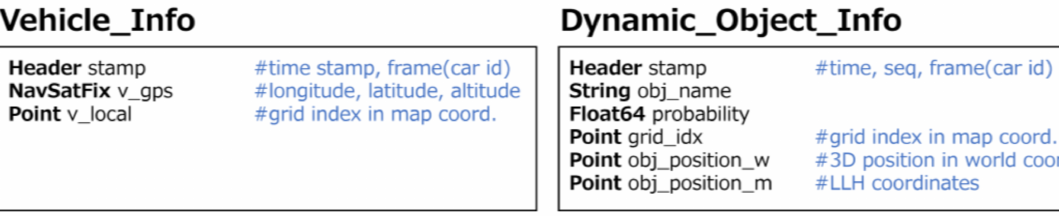
Figure 5. Message